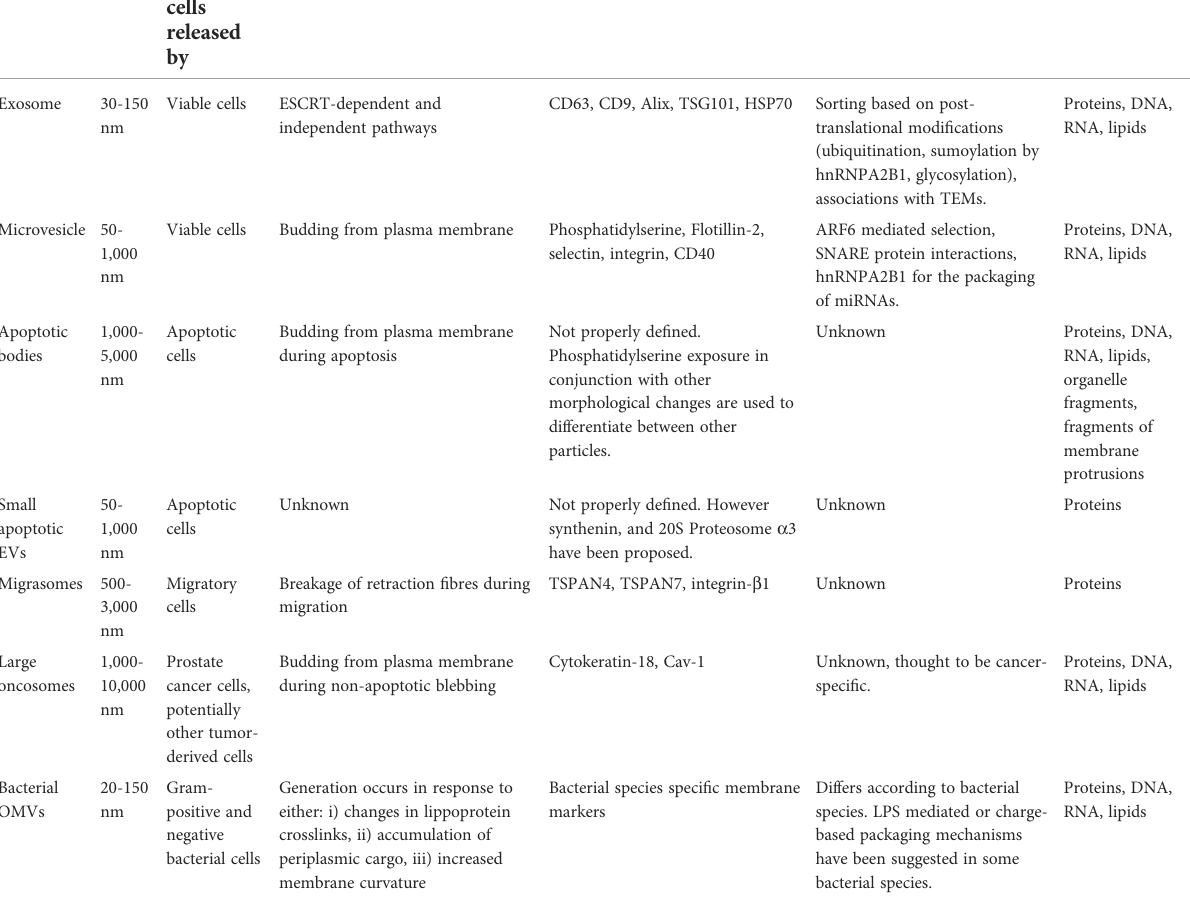
TABLE 1 Comparison between different extracellular vesicle